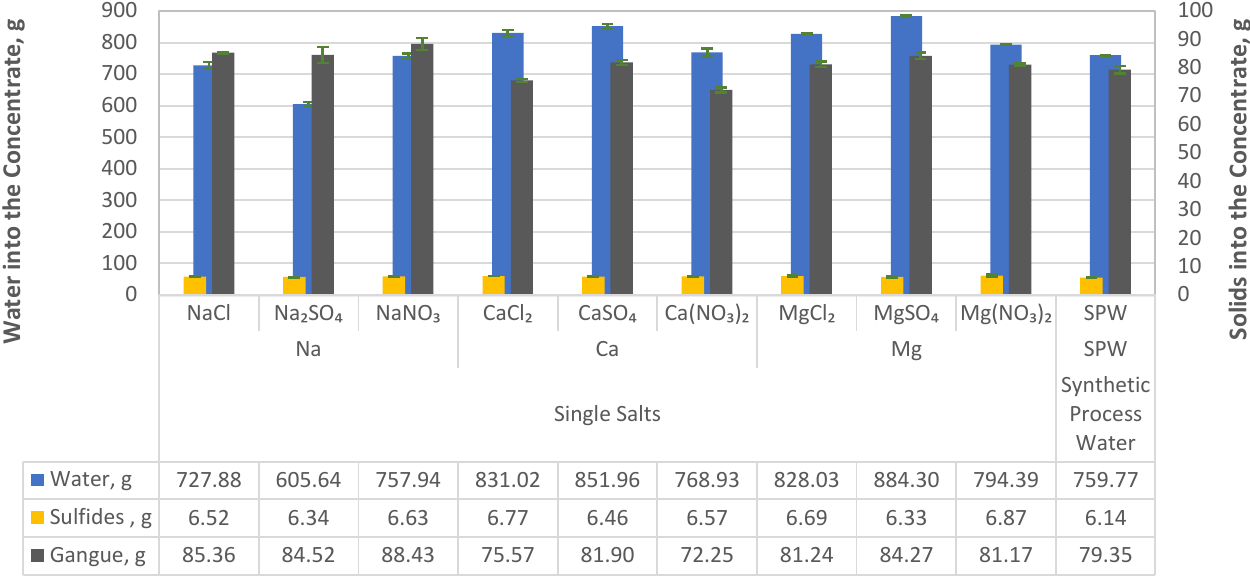
Figure 3. Amounts of water, total sulphides, and total gangue reporting to the concentrate for all single salts and SPW in a three-phase system.